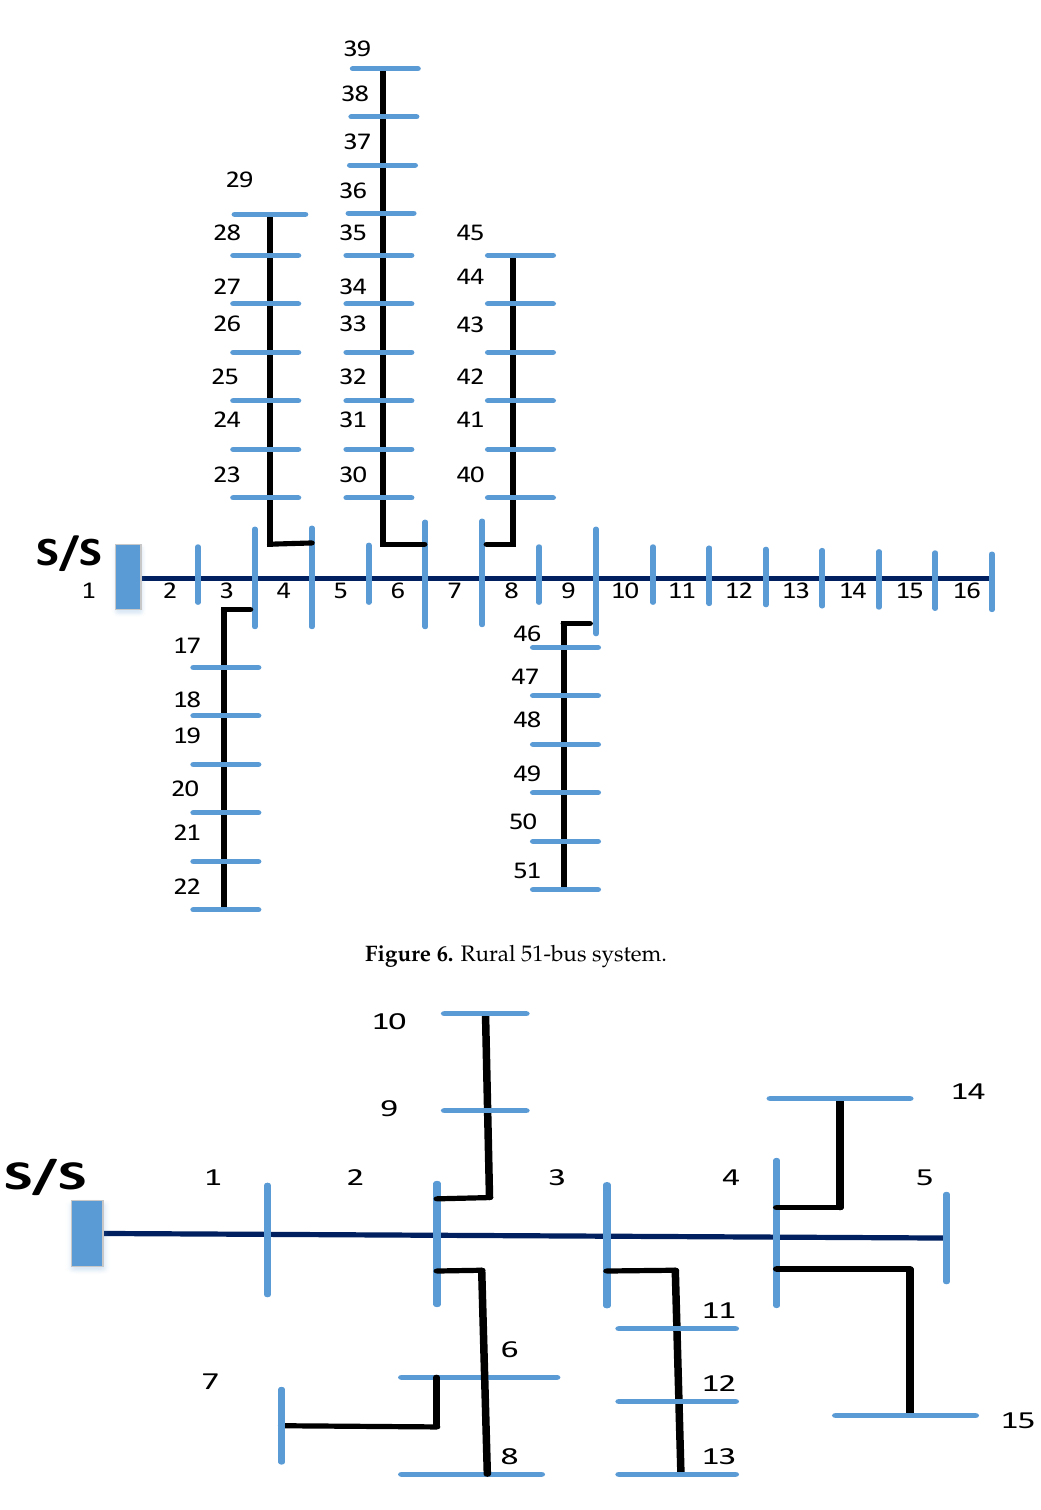
Figure 7. IEEE 15-bus system.